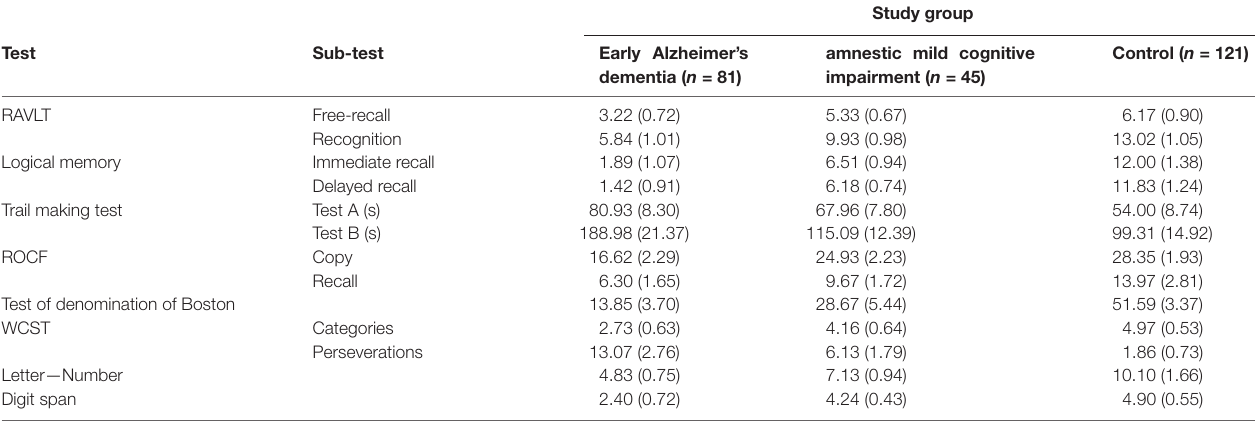
RAVLT, Rey Auditory Verbal Learning Test; ROCF, Rey-Osterrieth Complex Figure; WCST, Wisconsin Card Sorting